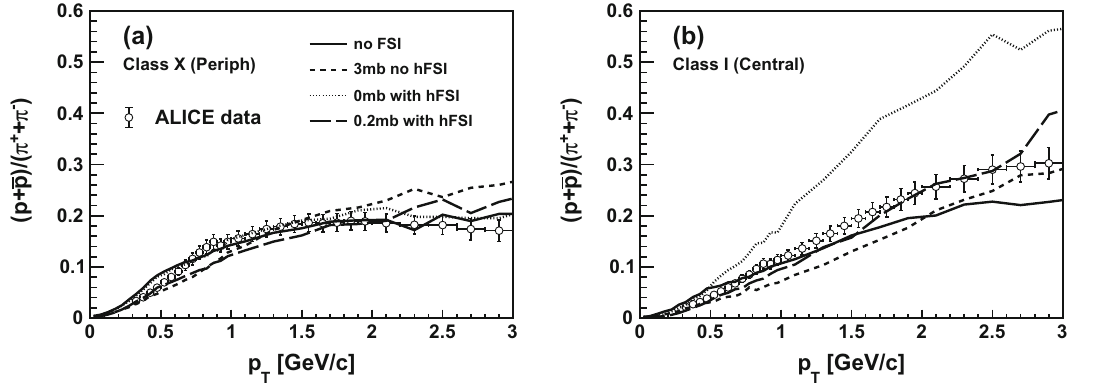
(short dashed line), only hadron rescatterings (dotted line) and com- bined parton/hadron rescatterings (long dashed line). Data are taken from